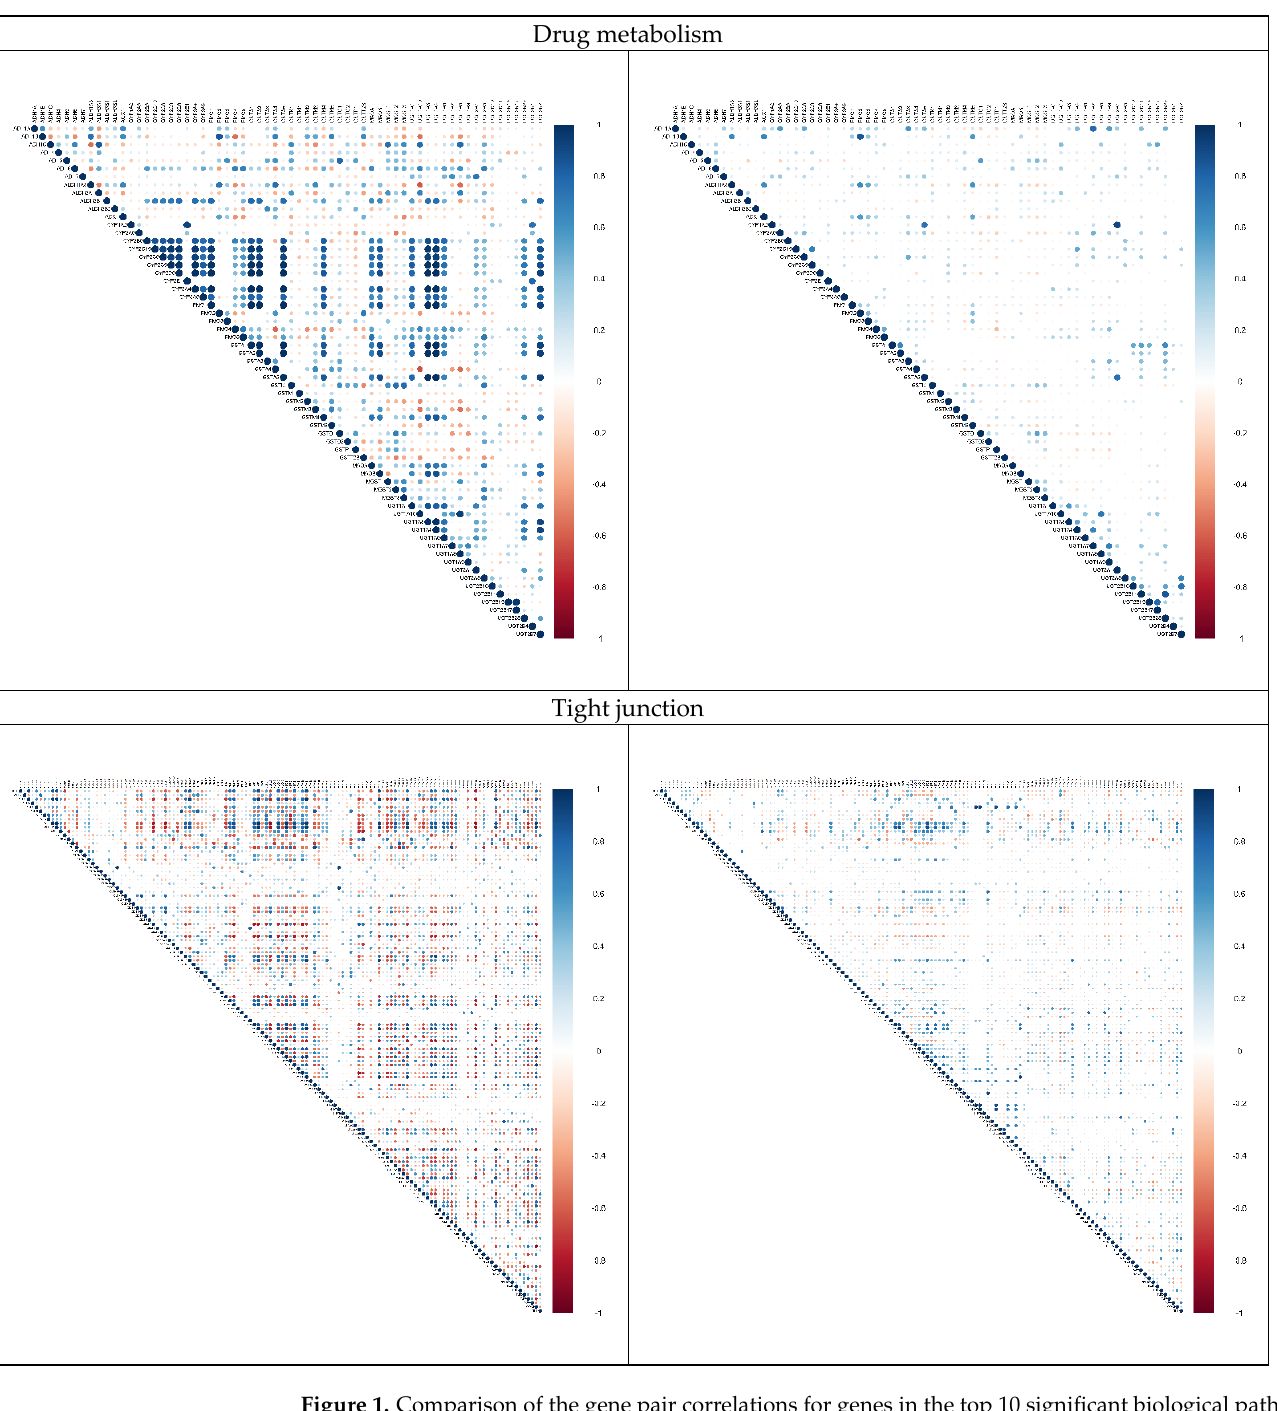
Figure 1. Comparison of the gene pair correlations for genes in the top 10 significant biological pathways between healthy controls ( left ) and colon cancer patients ( right ). The 10 biological pathways are neuroactive ligand–receptor interaction, systemic lupus erythematosus, cytokine–cytokine receptor interaction, pathways in cancer, bile secretion, Wnt signaling pathway, cell adhesion molecules, metabolism of xenobiotics by cytochrome P450, drug metabolism, and tight junction. Positive and negative correlations were shown in blue and red, respectively.